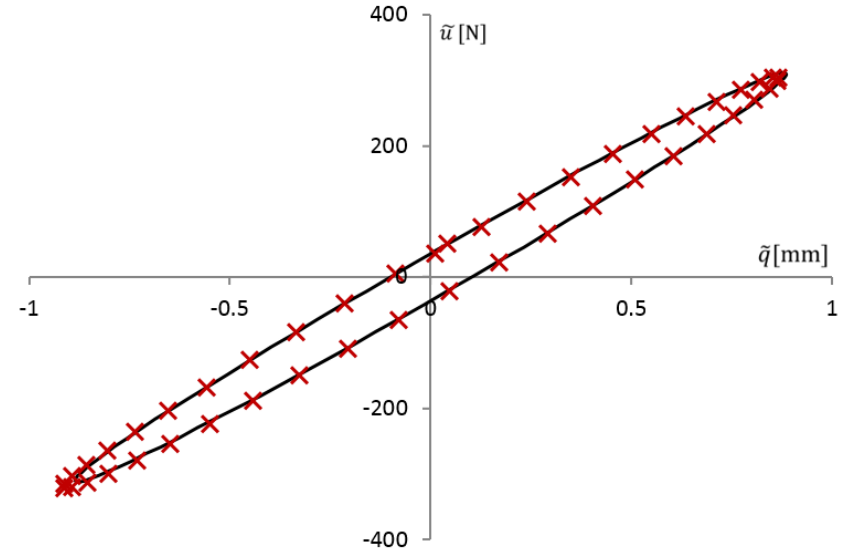
Figure 9. Relationship between force and displacement in the shear test: points-results of laboratory measurements, solid line-approximating